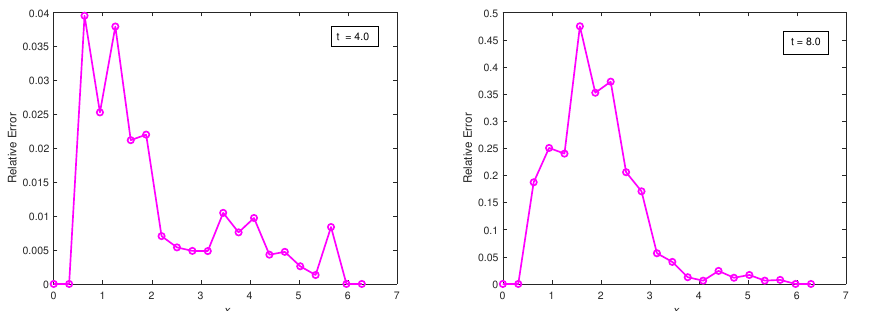
Figure 23. Plots of relative errors vs. x at times t = 0.10, 2.0, 4.0, 8.0, using the classical finite difference scheme with ∆ t = 10 − 2 and ∆ x =